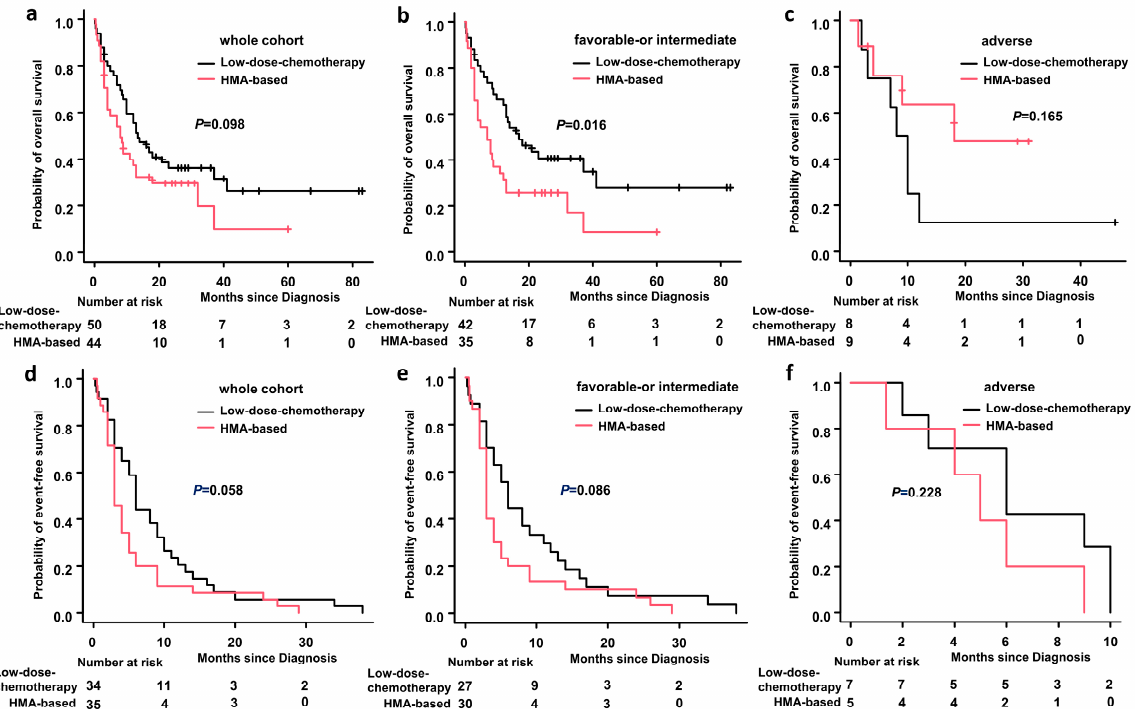
Figure 3. Overall survival and event-free survival: ( a ) overall survival (OS) for the whole cohort; ( b ) OS for favorable- or intermediate-risk patients; ( c ) OS for adverse-risk patients; ( d ) event-free survival (EFS) for the whole cohort; ( e ) EFS for favorable- or intermediate-risk patients; and ( f ) EFS for adverse -risk patients. Abbreviations: HMA-based, hypomethylating agents combined with low dose chemotherapy.